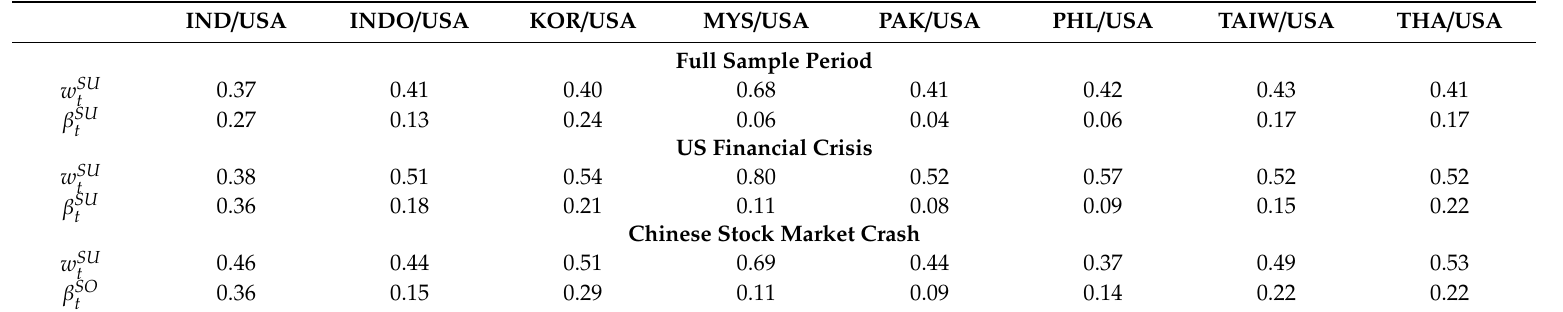
Table 8. Optimal Weights and Hedge Ratios for Asia / USA pairs.